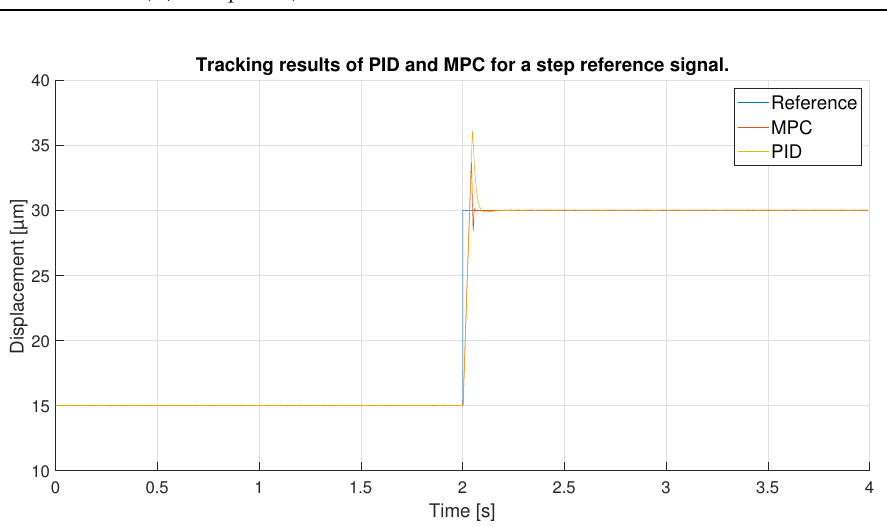
Figure 28. Tracking results of PID and MPC for a step reference